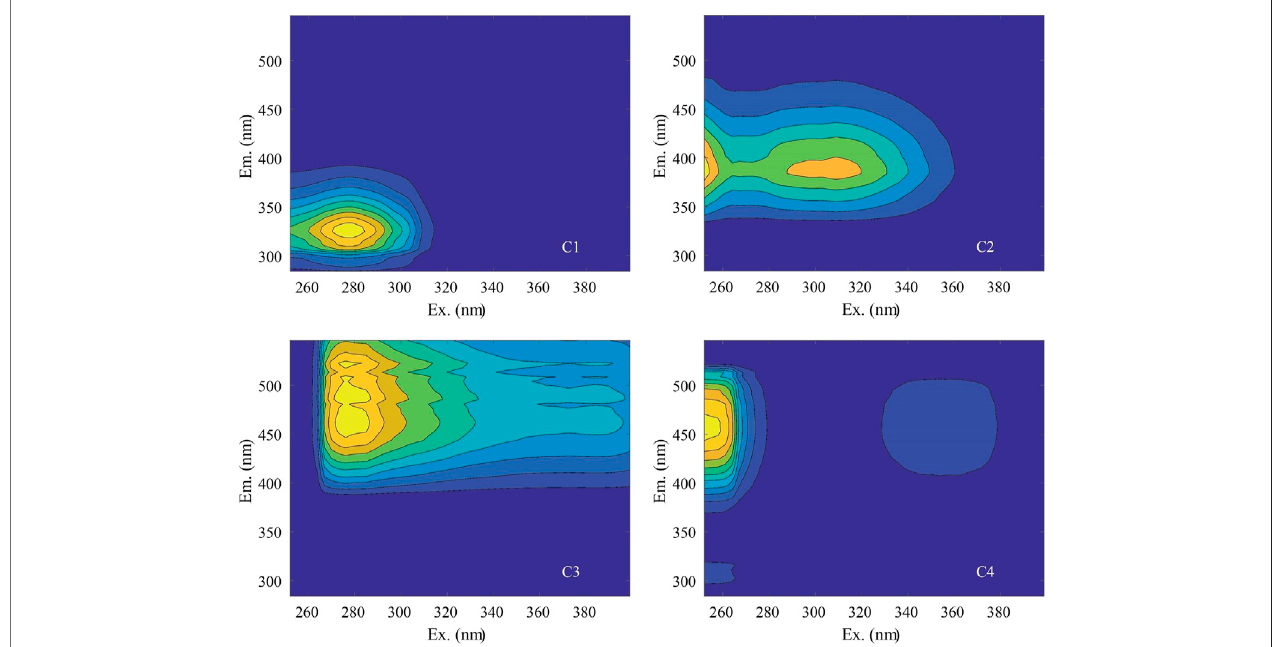
FIGURE 4 | Fluorescence spectra of four PARAFAC components identi fi ed in this